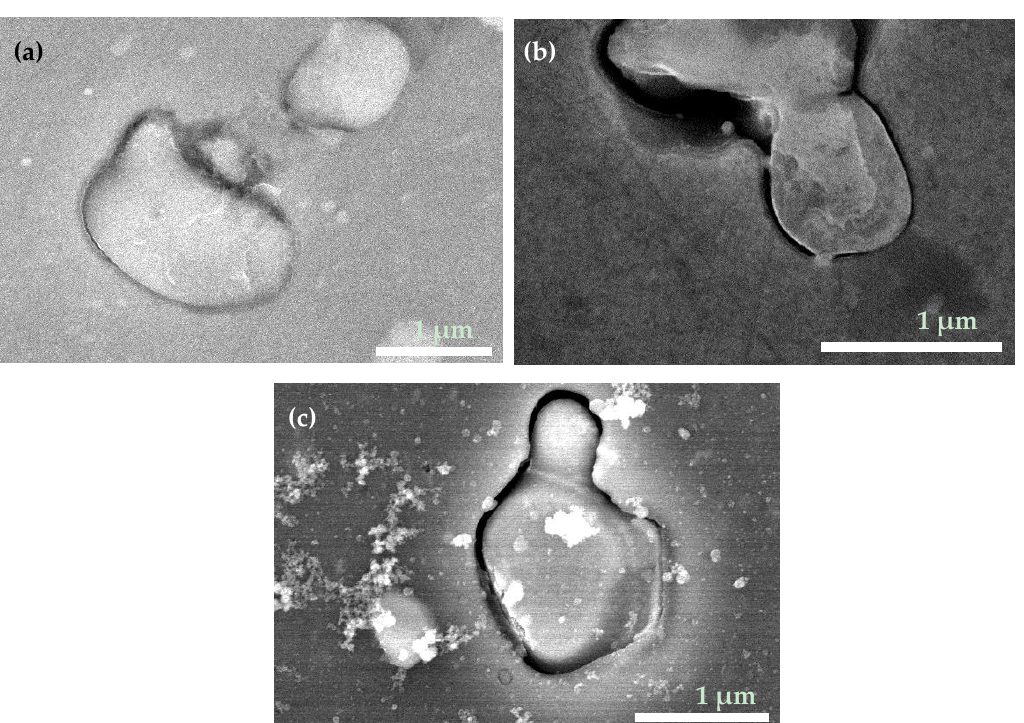
Figure 5. Surface SEM images of sample 2 after immersion into DI water for 24 h ( a , b ) and after sonication in DI for 60 min ( c ). Trenches surrounding surface intermetallic particles are seen, being a sign of electrochemical corrosion [8,41 – 43,49,50].